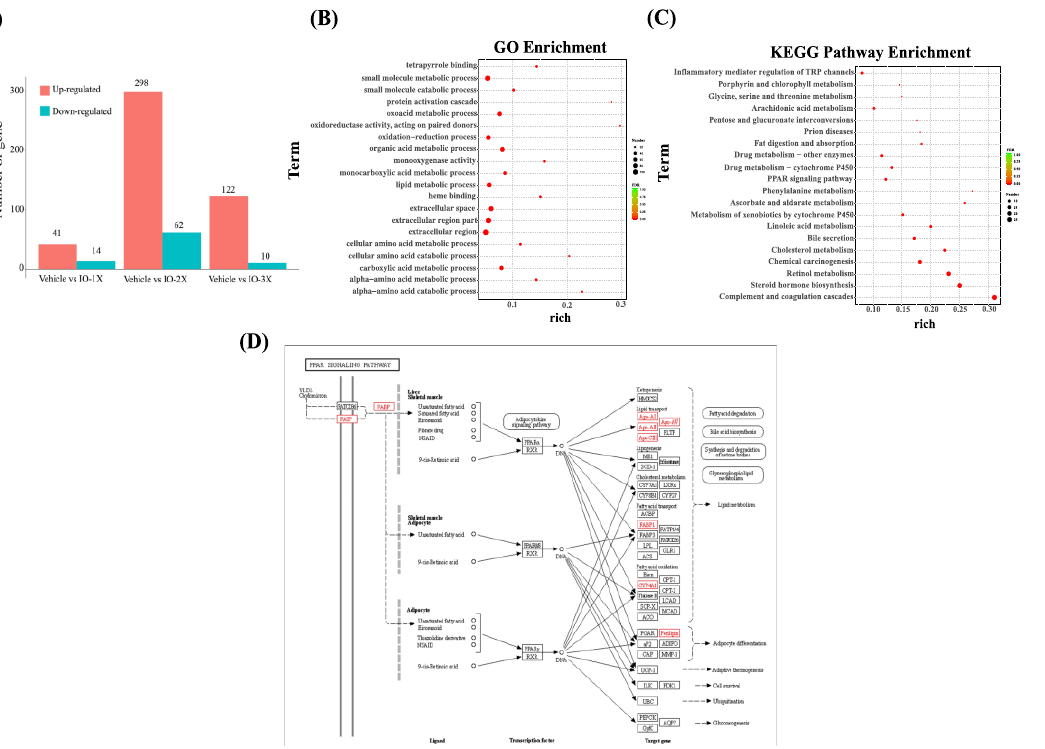
Figure 7. IO supplementation of gene expression analysis in mouse muscle. ( A ) Number of differen- tially expressed genes in the vehicle and IO mouse groups at significant expression levels in muscle. ( B ) Gene ontology analysis of the top 20 most enriched pathways following IO treatment based on target genes. ( C ) KEGG pathway enrichment of IO treatment. Top 20 pathways enriched based on target genes (the abscissa is the enrichment factor, the ordinate is the pathway name, the size of the dot indicates the number of target genes, and the color represents the p -value). ( D ) Analysis of the PPAR signaling pathway. Red represents the targets of the IO treatment in the upregulation of the PPAR